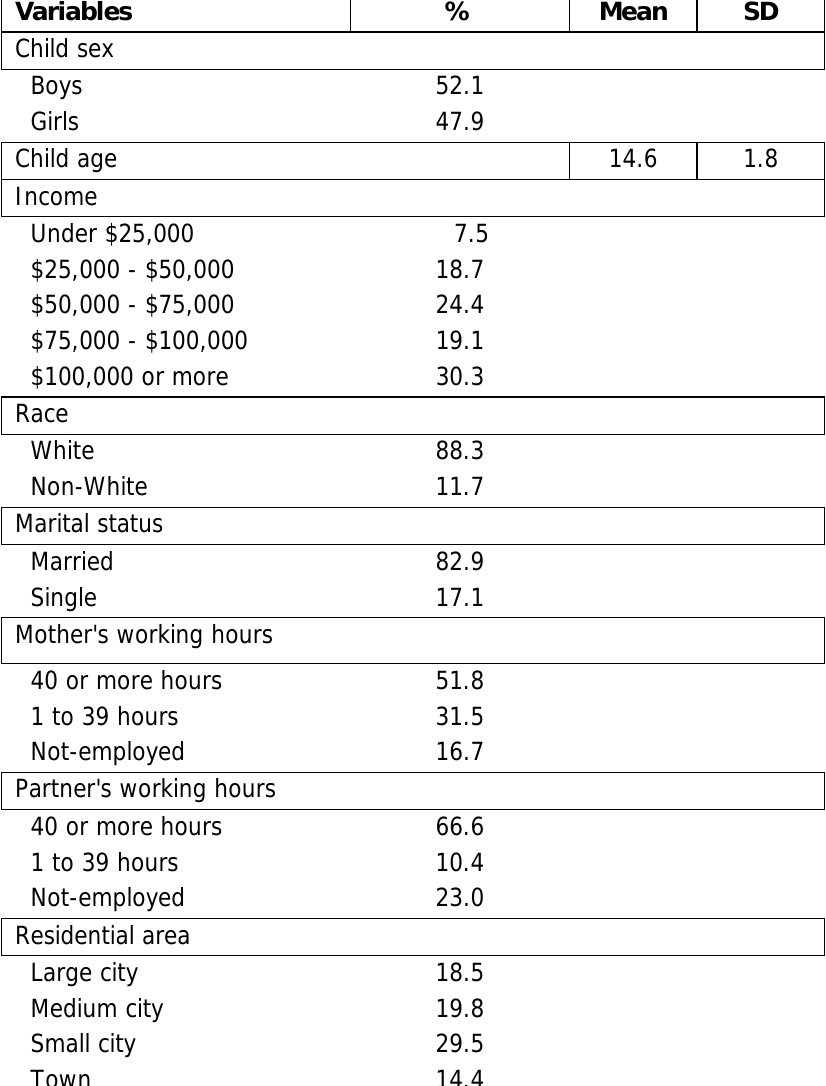
Descriptive Statistics (Note. Sample is